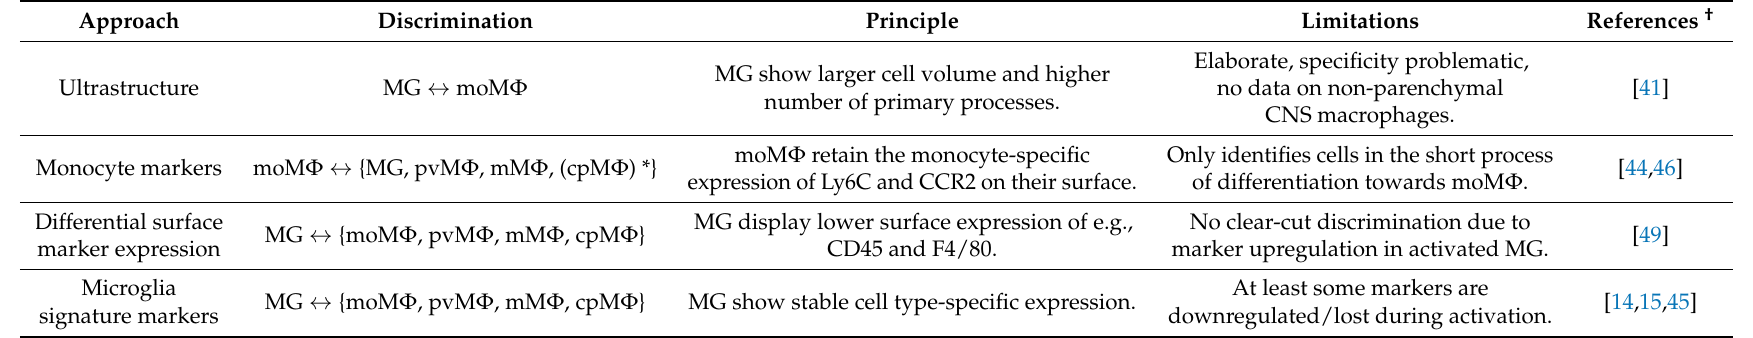
Table 1. Methods to discriminate infiltrating from resident CNS